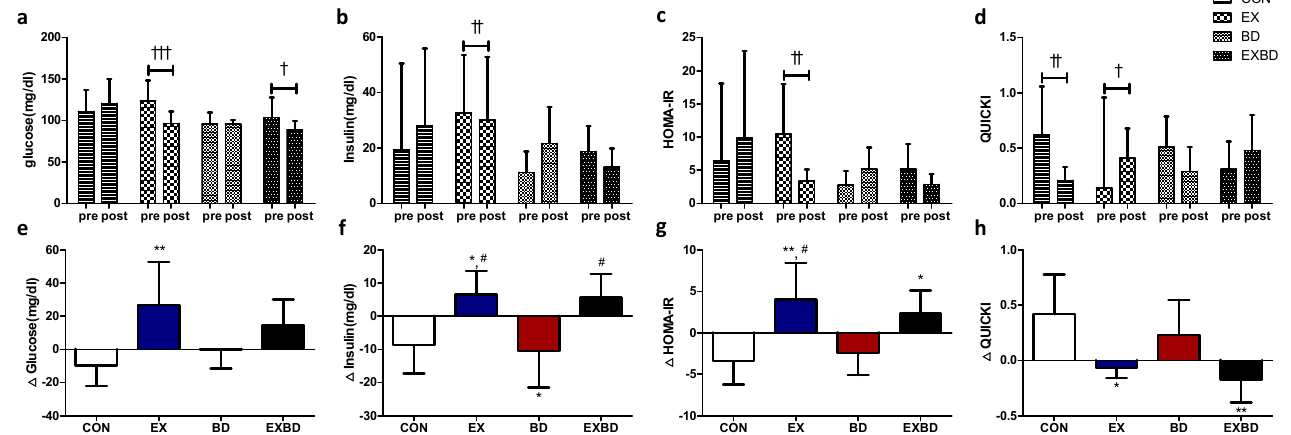
Figure 3. Effect of 16 weeks of aqua exercise and burdock intake on insulin resistance in older women with metabolic syndrome. After the intervention, compared with the baseline values, ( a ) glucose levels were decreased in the EX and EXBD groups, ( b ) insulin levels were decreased in the EX group, ( c ) the HOMA-IR was decreased in the EX group, and ( d ) the QUICKI was decreased in the CON group and increased in the EX group. One-way analysis of variance was used to compare the variation in insulin resistance ( e – h ). Data are presented as the mean ± standard deviation. † p < 0.01, †† p < 0.01, ††† p < 0.001; before vs. after intervention. * p < 0.05, ** p < 0.01 vs. CON, # p < 0.05 vs. BD.